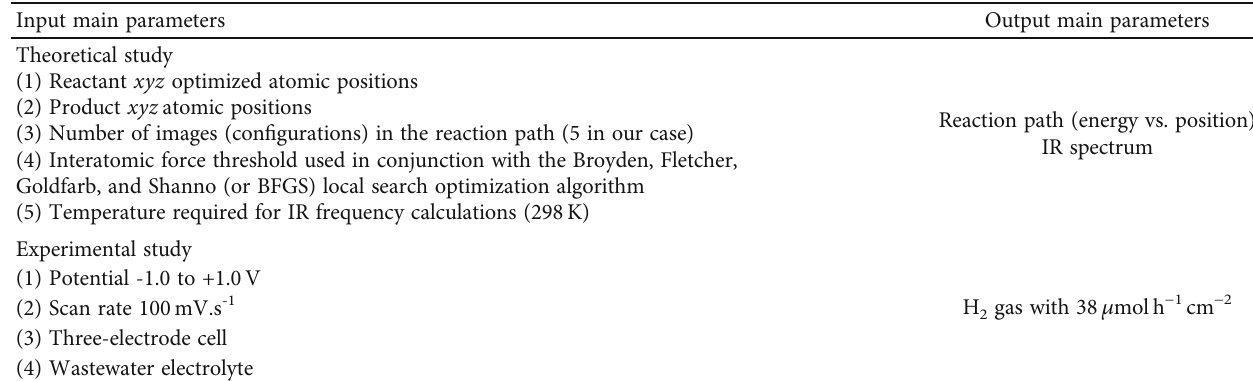
Table 5: The input and output parameters used in the present theoretical and experimental study. Input main